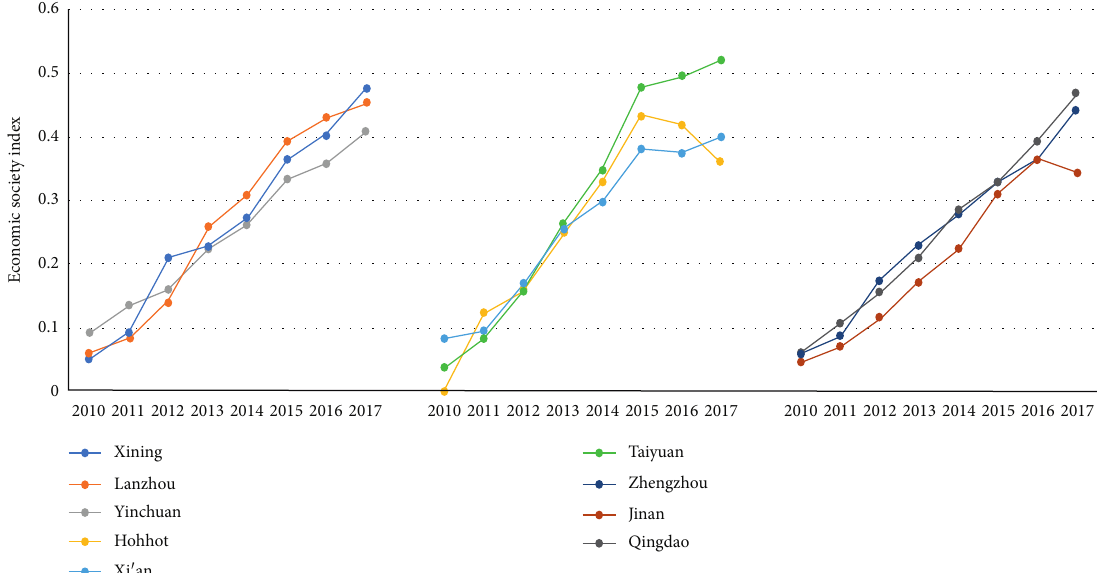
Figure 2: Change trend of comprehensive level social economy.